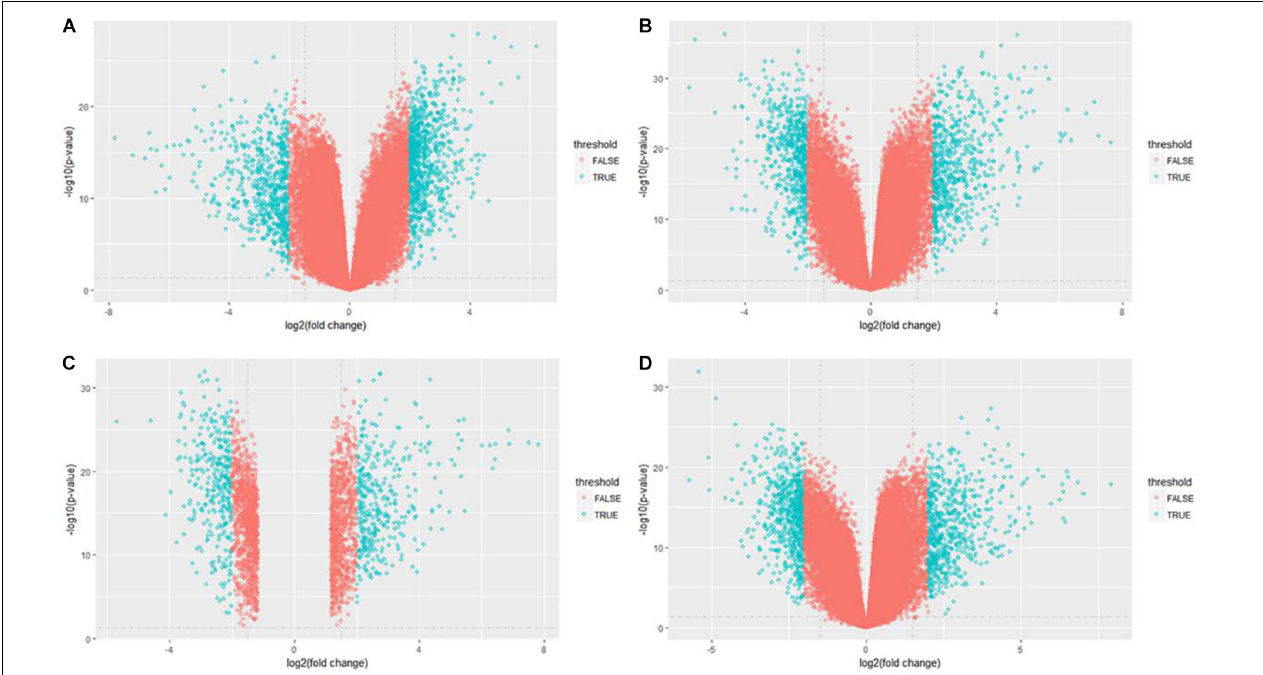
FIGURE 3 | Volcano plot of differentially expressed genes in GSE21510 gene profiling data. (A) Stage I. (B) Stage II. (C) Stage III. (D) Stage IV.